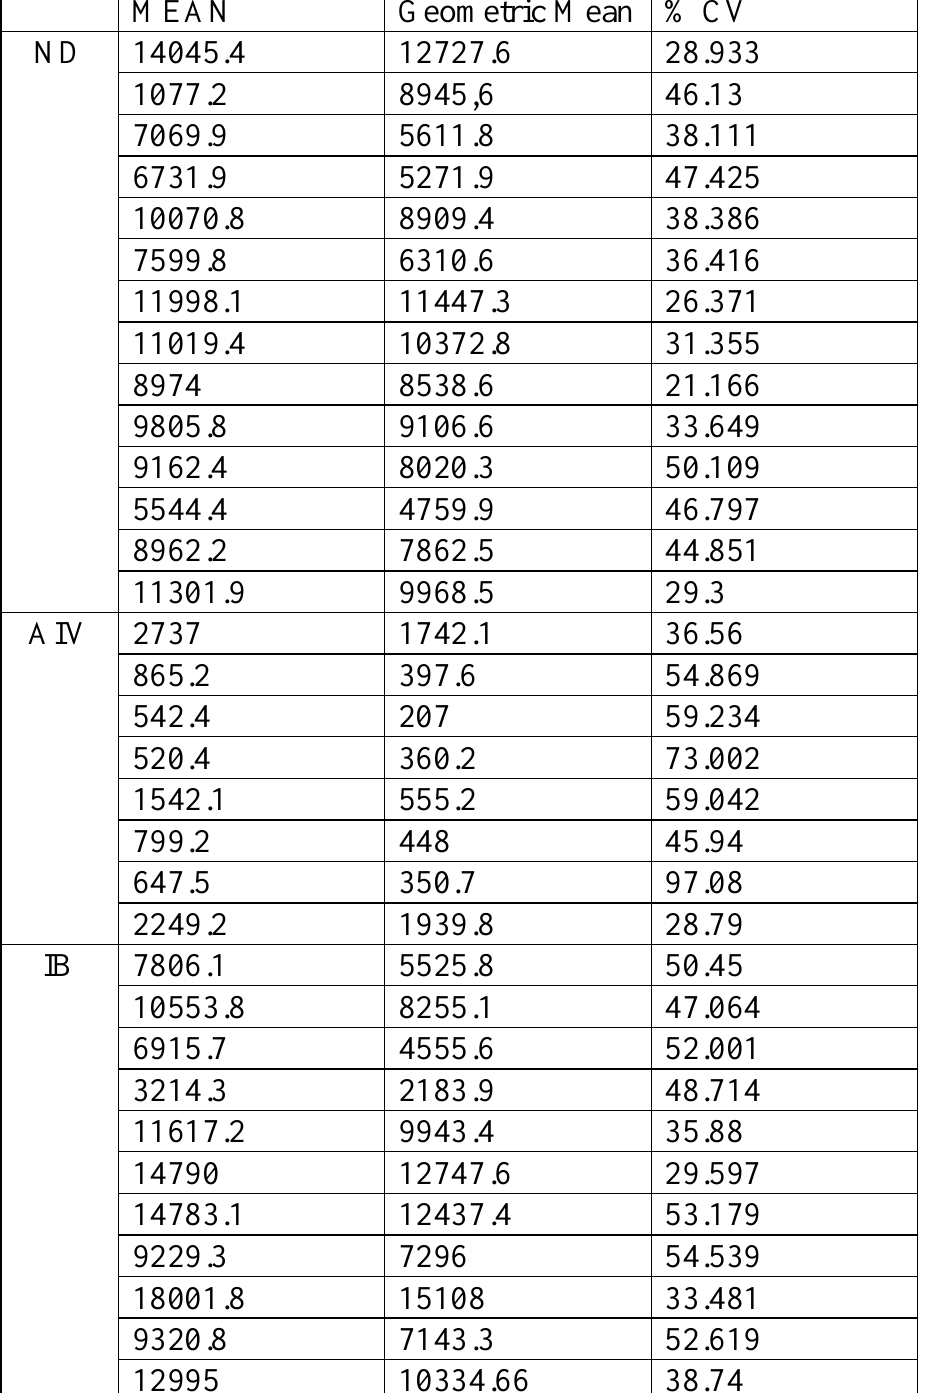
Table (2): ELISA results of ND, AIV and IB antibody titres of 2005 MEAN Geometric Mean